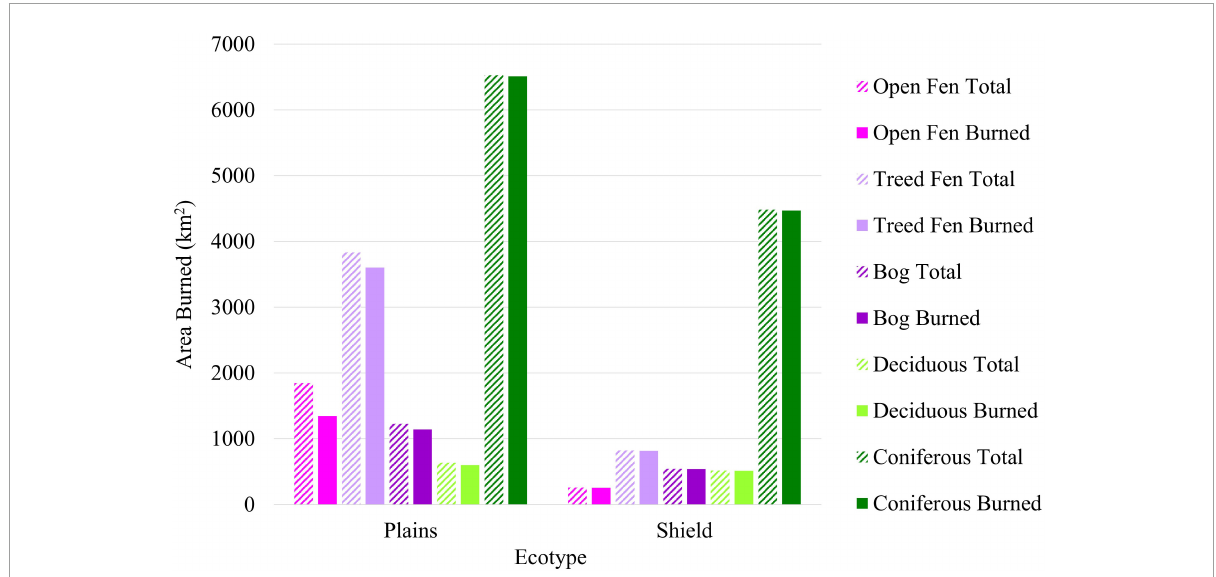
FIGURE5 Plot of actual area within fire perimeters (hashed bars) and area burned (solid bars) in km 2 by ecotype for the Taiga plains and shield.